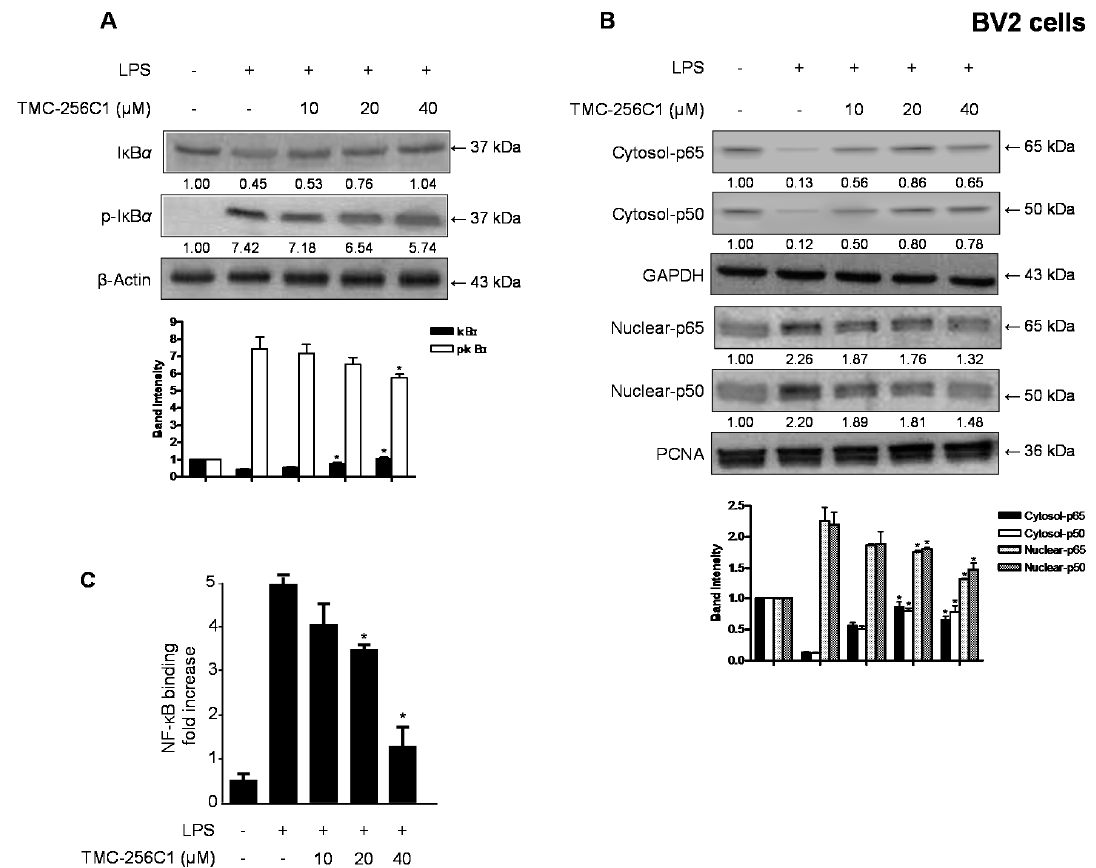
Figure 5 . Effects of TMC-256C1 on LPS-induced NF- κ B activation ( A – C ). Following pretreatment with